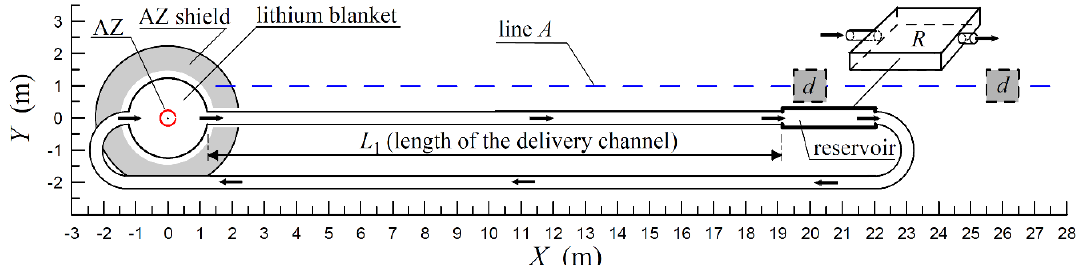
Figure 3 . The principal scheme of (cid:22) (cid:23) e -source with variable (regulated) spectrum for short-baseline experiment. The dimensions in the (cid:12)gure correspond to actual sizes used in the simulation. Liquid lithium substance in the blanket (activated by neutrons from Active Zone) is pumped continuously through the delivery channel to the remote reservoir (which is set close to the (cid:22) (cid:23) e -detector) and further back to the blanket. The examples of detector positions are labeled as d . The 3-dimensional view of the reservoir (label R ) is given separately. At simulation of the antineutrino disappearance we used the coordinates of points along the line A ( y = 1). The rate of pumping can be smoothly varied by the installation (not showen) of regime